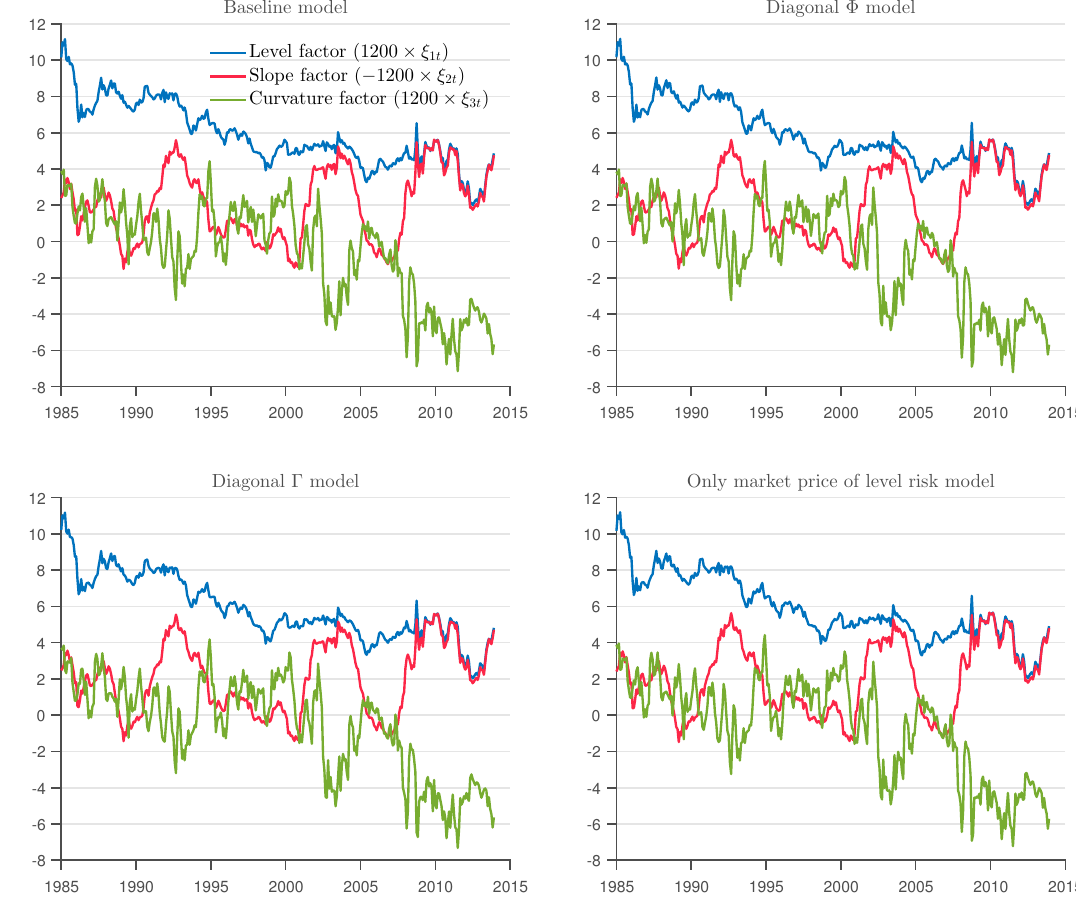
Figure 1. Estimated unobserved factors and empirical level, slope and